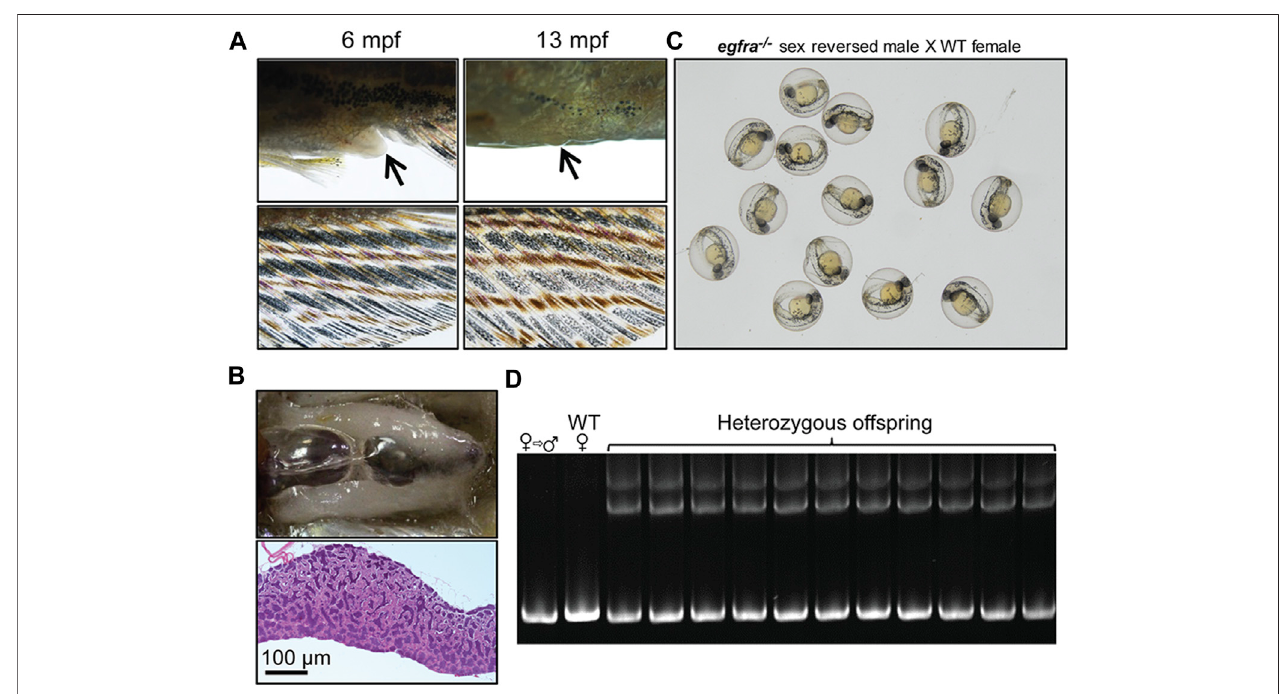
FIGURE10| Developmentofsecondarysexual characteristicsduring sexreversal and fertility test forsex-reversed males. (A) Protruding genitalpapilla (upperleft, arrow )andalightanal fi n(lowerleft)wereobservedin egfra − / − femalesat6 mpf.Thegenitalpapilladisappearedandtheanal fi nturnedgoldenincolorinthesame fi shat 13 mpf. (B) The sex-reversed males ( egfra − / − ) showed normal testis and spermatogenesis at 13 mpf. (C) The sex-reversed males were fertile and could spawn with WT females to produce normal embryos. (D) All the offspring of sex-reversed males and WT females were heterozygous egfra +/ − as genotyped by